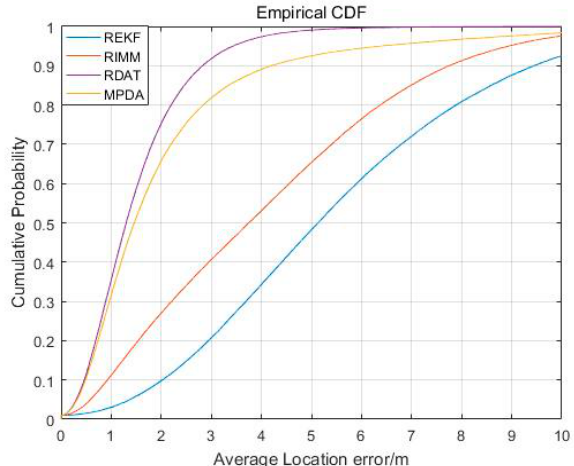
Figure 10. The CDF result of the localization error.